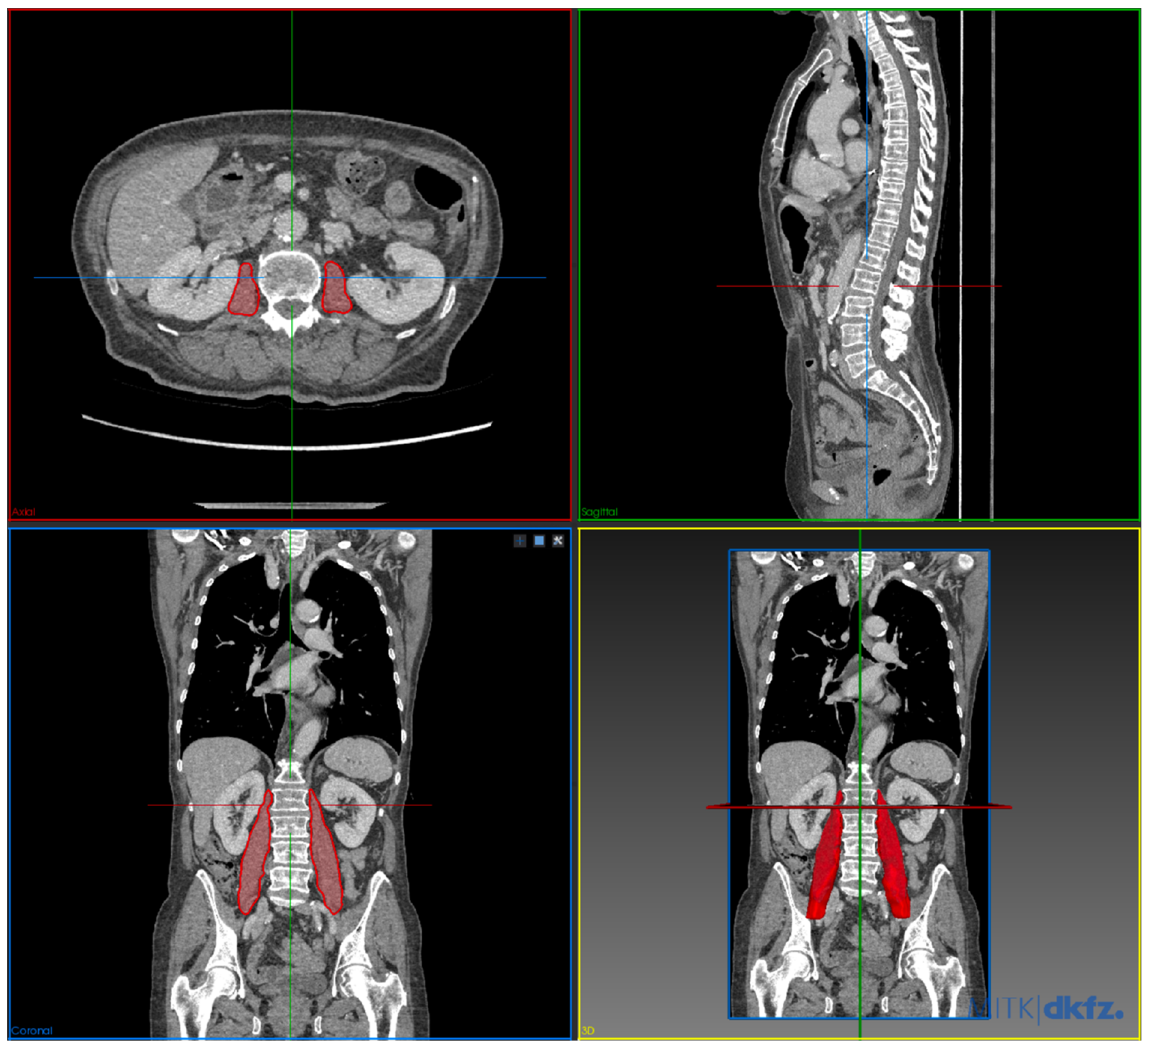
Figure 2. Example of manual 3D segmentation of psoas muscle volume in multiplanar reformation and 3D reconstruction.